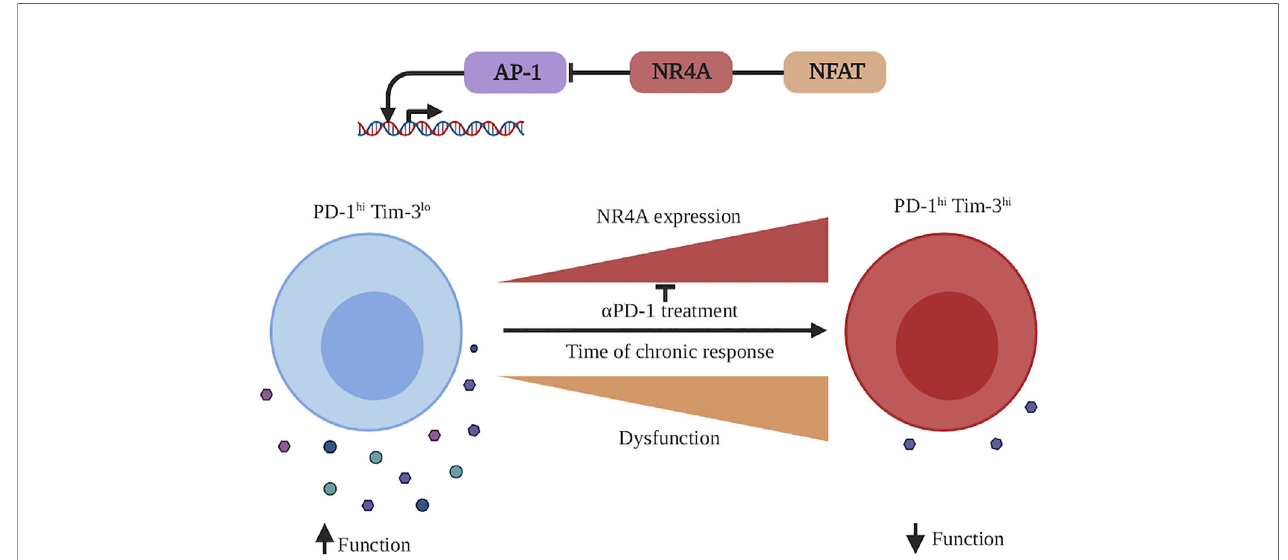
FIGURE 3 | NR4A involvement in CD8+ T cell exhaustion during a chronic immune response. During a chronic immune response, antigen persistence as well as in fl ammation milieu will induce CD8 + T cell exhaustion. This state is characterized by the acquisition of the expression of different inhibitory receptors (as PD-1, Tim-3 etc.), which dampens CD8 + T cell function to protect the organism against the chronically activated CD8 + T cells. CD8 + T cell exhaustion is accompanied by an increased transcription of Nr4a1, Nr4a2 , and Nr4a3 . At the molecular level, NR4A family members cooperate with NFAT and potentially other transcription factors to decrease the activity of AP-1 (bZIP family transcription factor) and increase the dysfunctional/exhaustion state of the CD8+ T cells. An effective reinvigorating therapy to reverse CD8 + T cell dysfunction is treatment with anti-PD-1 antibodies, which decreases the Nr4a transcription. This fi gure was created with Biorender.com.